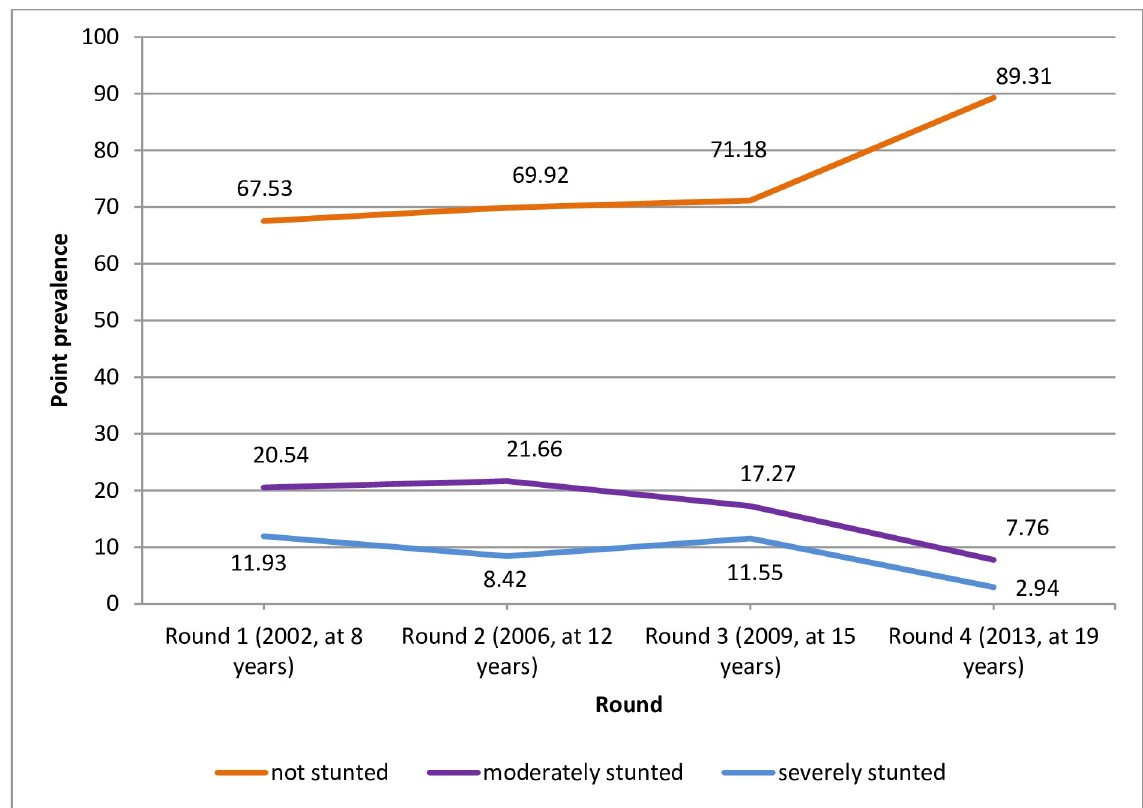
Fig 3. Cross-sectional (point) prevalence of stunting in the older cohort across the four rounds (childhood to youthhood), Ethiopia, 2002–2013.